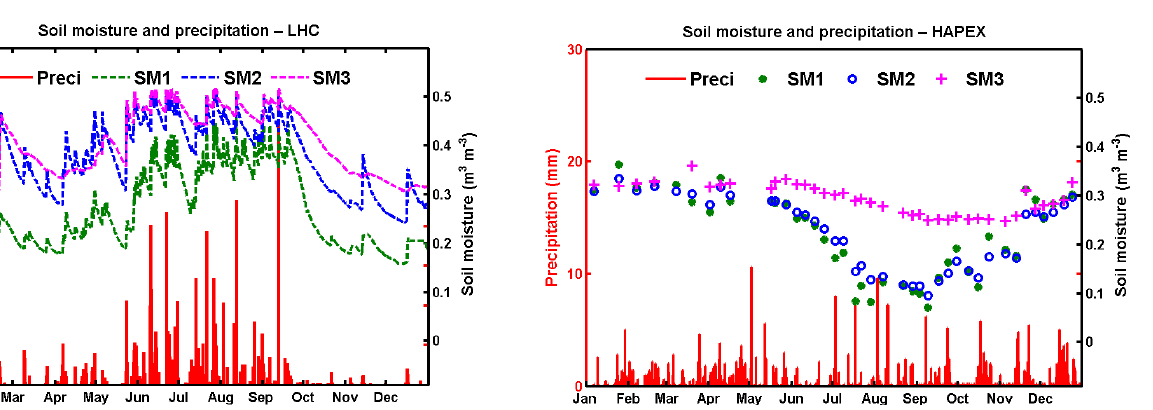
Figure 2. The hourly soil moisture (curves, right axis) and precipi- tation (red bars, left axis) observed at LHC during 2010. SM1, SM2 and SM3 represent soil moisture at 10cm (green dashed curve), 40cm (blue dashed curve; average of 30 and 50cm observations) and 90cm (magenta dashed curve), respectively.